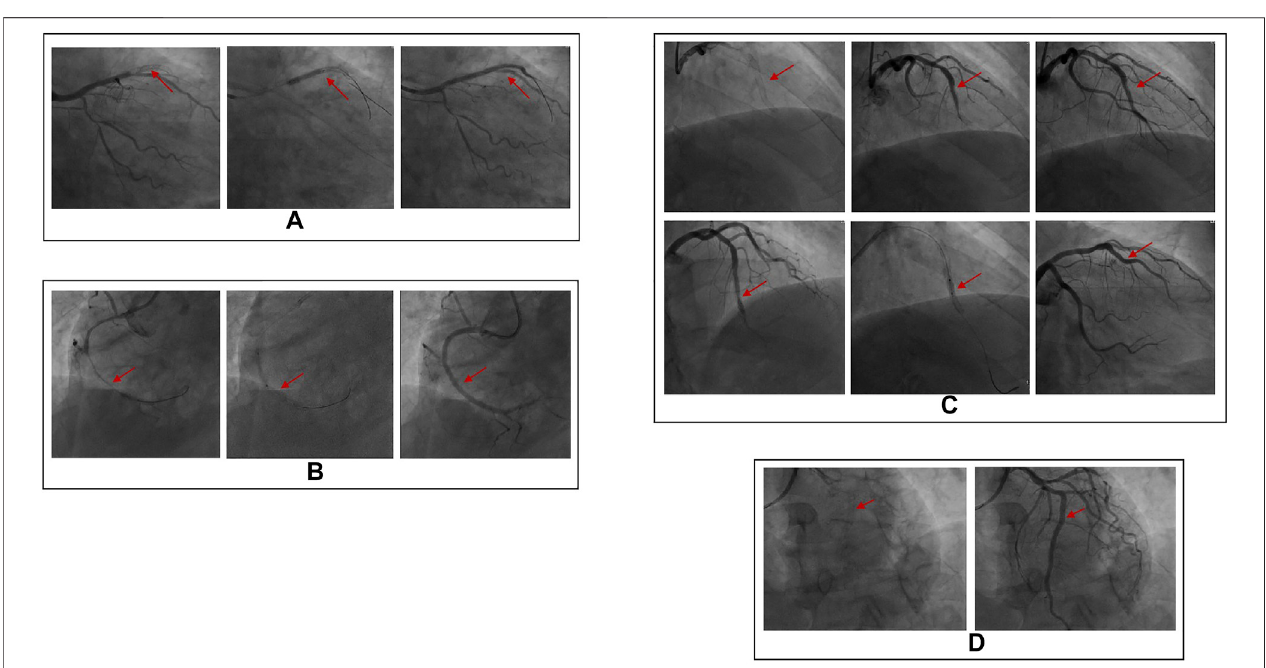
FIGURE 1 | DSA images of plaque formation in stent and the severity of plaque on vascular blockage. (A) In stent restenosis (complete occlusion), stent shadow can be seen in the proximal part of lad, complete occlusion in the middle part of LAD (100% stenosis), TIMI grade 0; (B) In stent restenosis (partial occlusion), stent shadowcanbeseenintheproximalpartofRCA,and70%stenosisintheproximalpartofRCA; (C) Thereareplaques(intimalhyperplasia)inthestent,stentshadowcan be seen in themiddle oflad, and intimal hyperplasia inthe stent. (D) There isno plaque (unobstructed blood fl ow)in the stent. The stentshadow can beseen in the proximal and middle part of RCA, and the blood fl ow in the stent is unobstructed.